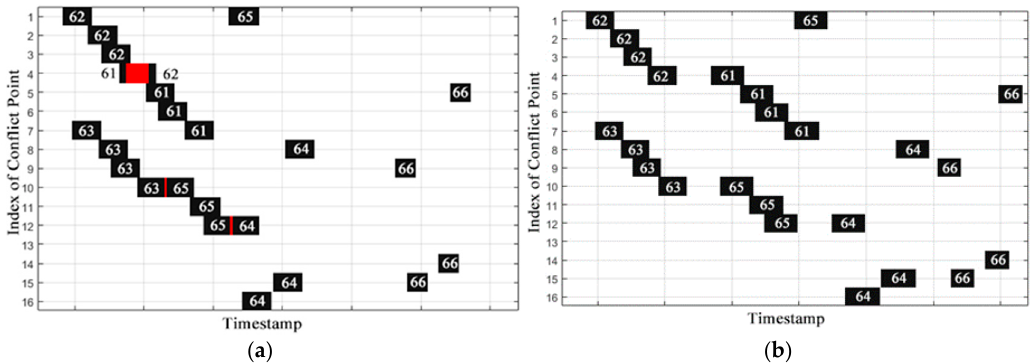
Figure 16. A multi-vehicle collision in the 150A test scenario. ( a ) Before speed control; ( b ) after speed control.